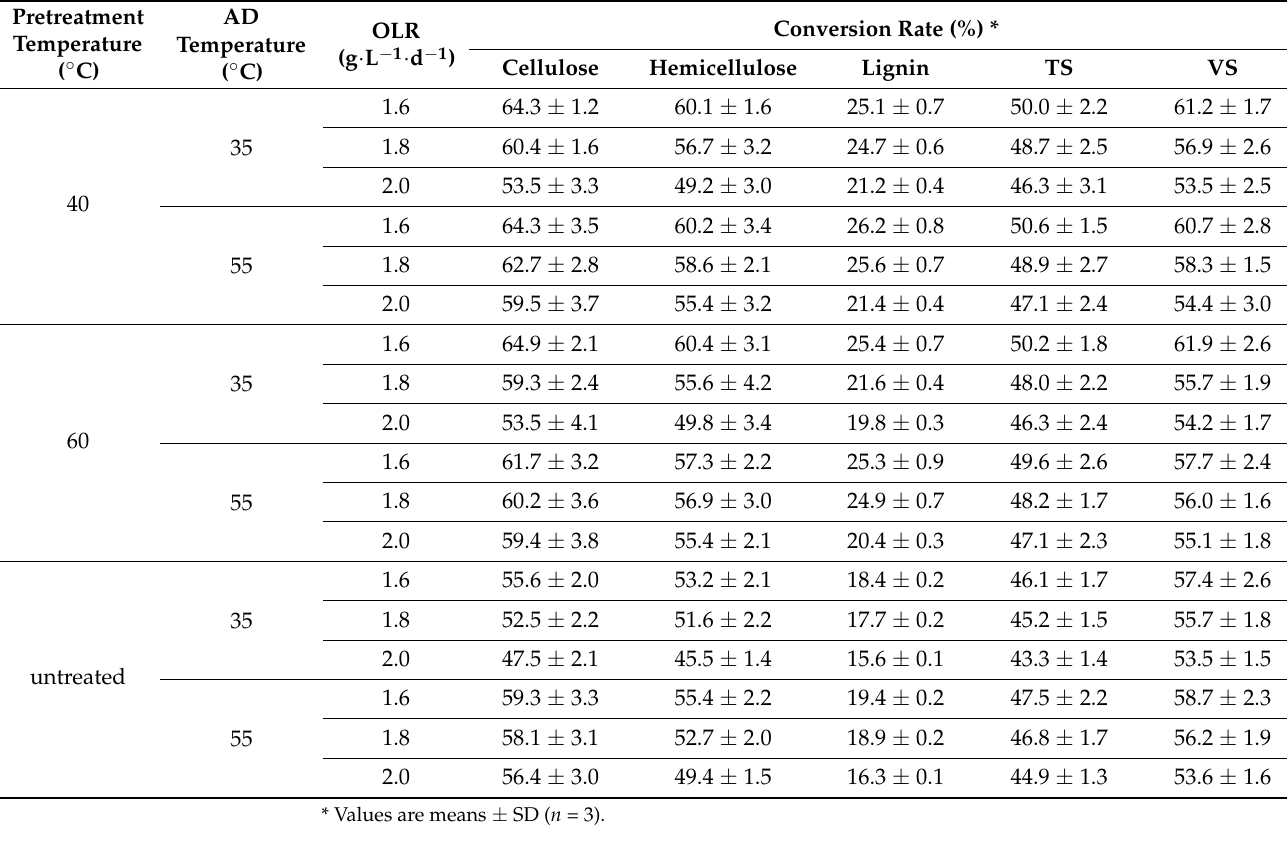
Table 5. Main components conversion rate of CS at different pretreatment and AD temperatures.